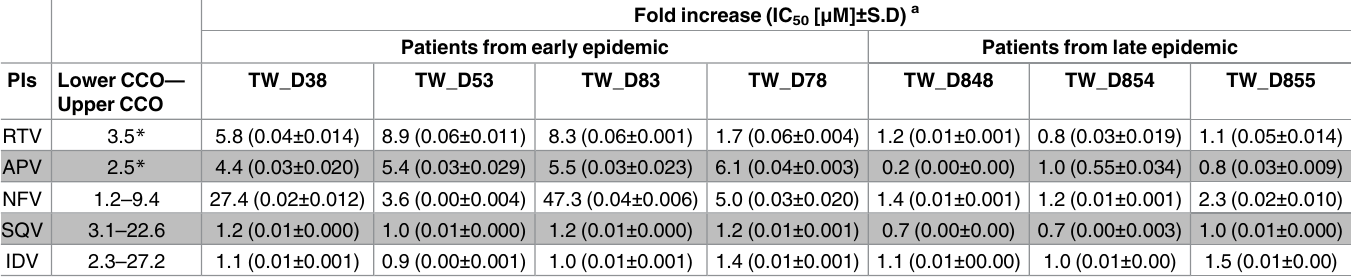
Table 2. Fold increaseof IC 50 of Taiwanese CRF07_BCfor various protease inhibitors.